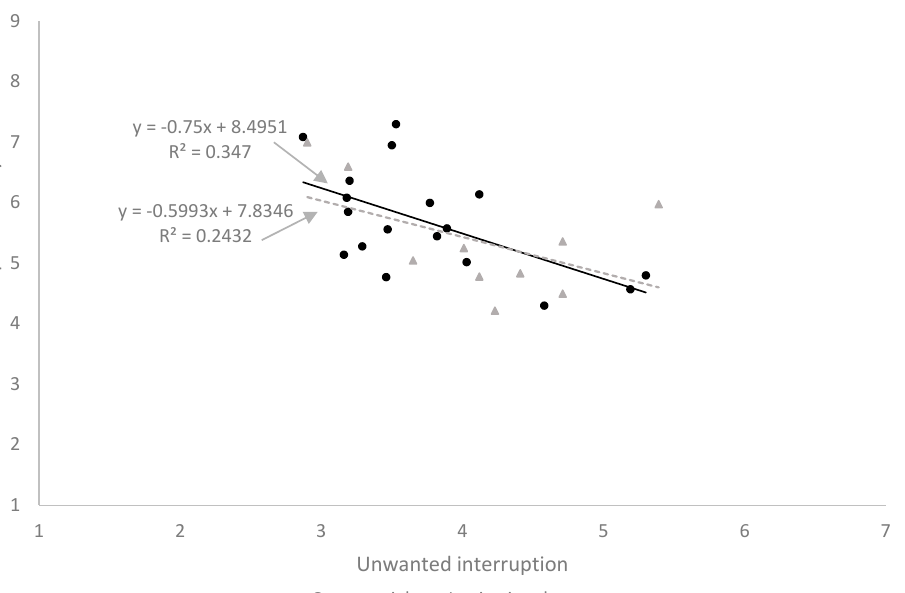
Figure 1. The scatter plot of the pilot study of sustainable building averages of unwanted interruptions against perceived productivity.